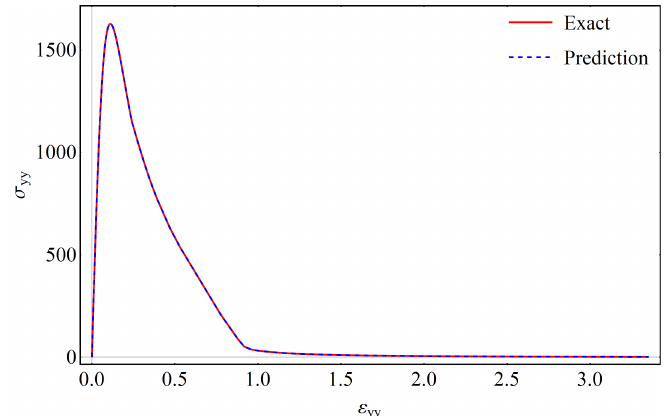
Figure 13. V-notch bar in tension. Validation of stress–strain behavior with NN formulation against FEM. The stress unit is [N/mm 2 ].